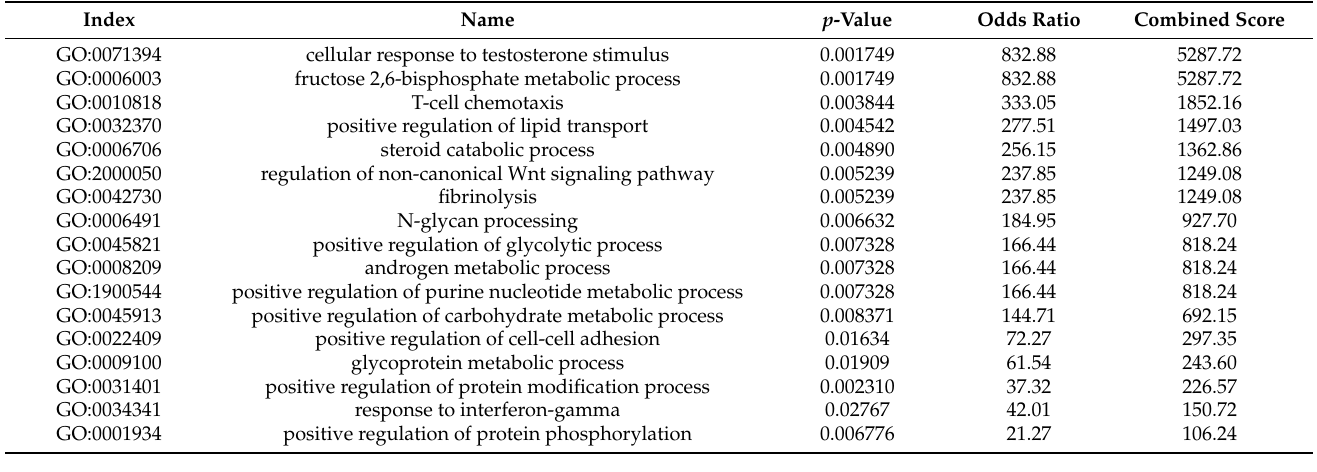
Table 2. Enriched biological processes associated with the MTSCPPC signature.